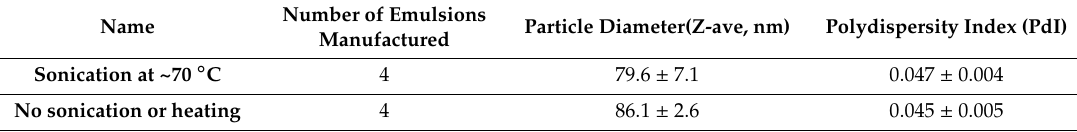
Table 2. E ff ect of sonication on emulsion droplet